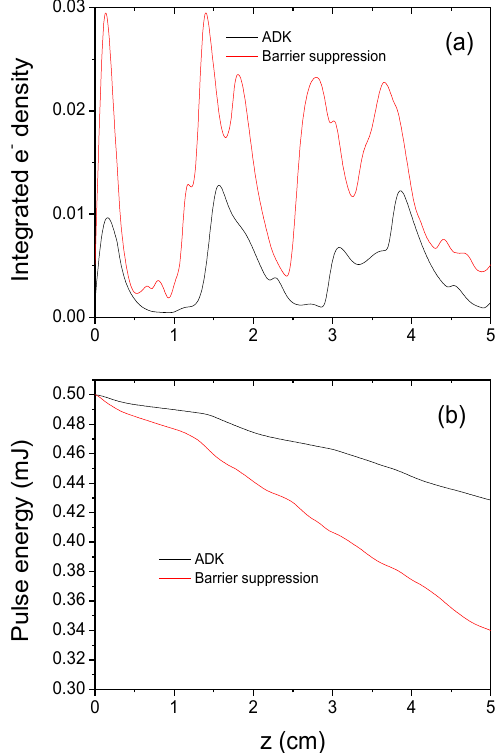
Fig.1 Total electron density (a) and pulse energy (b) as a function of z position along the HCW, for two ionization models, as detailed in the text.